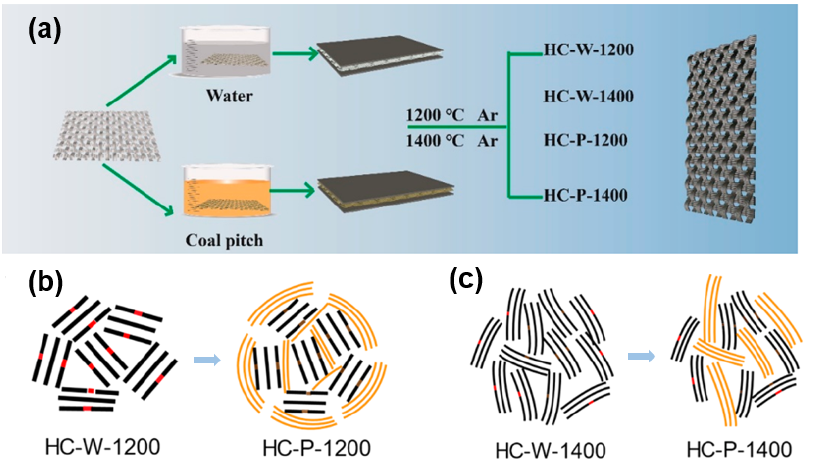
Figure 14. ( a ) Schematic diagram of the synthesis of different samples, HC–P in coal-pitch impregnation and HC–W in water impregnation. ( b , c ) Schematic diagram of structure: red dots represent the defect sites and yellow lines represent the product of coal-pitch (soft carbon coating) [112].